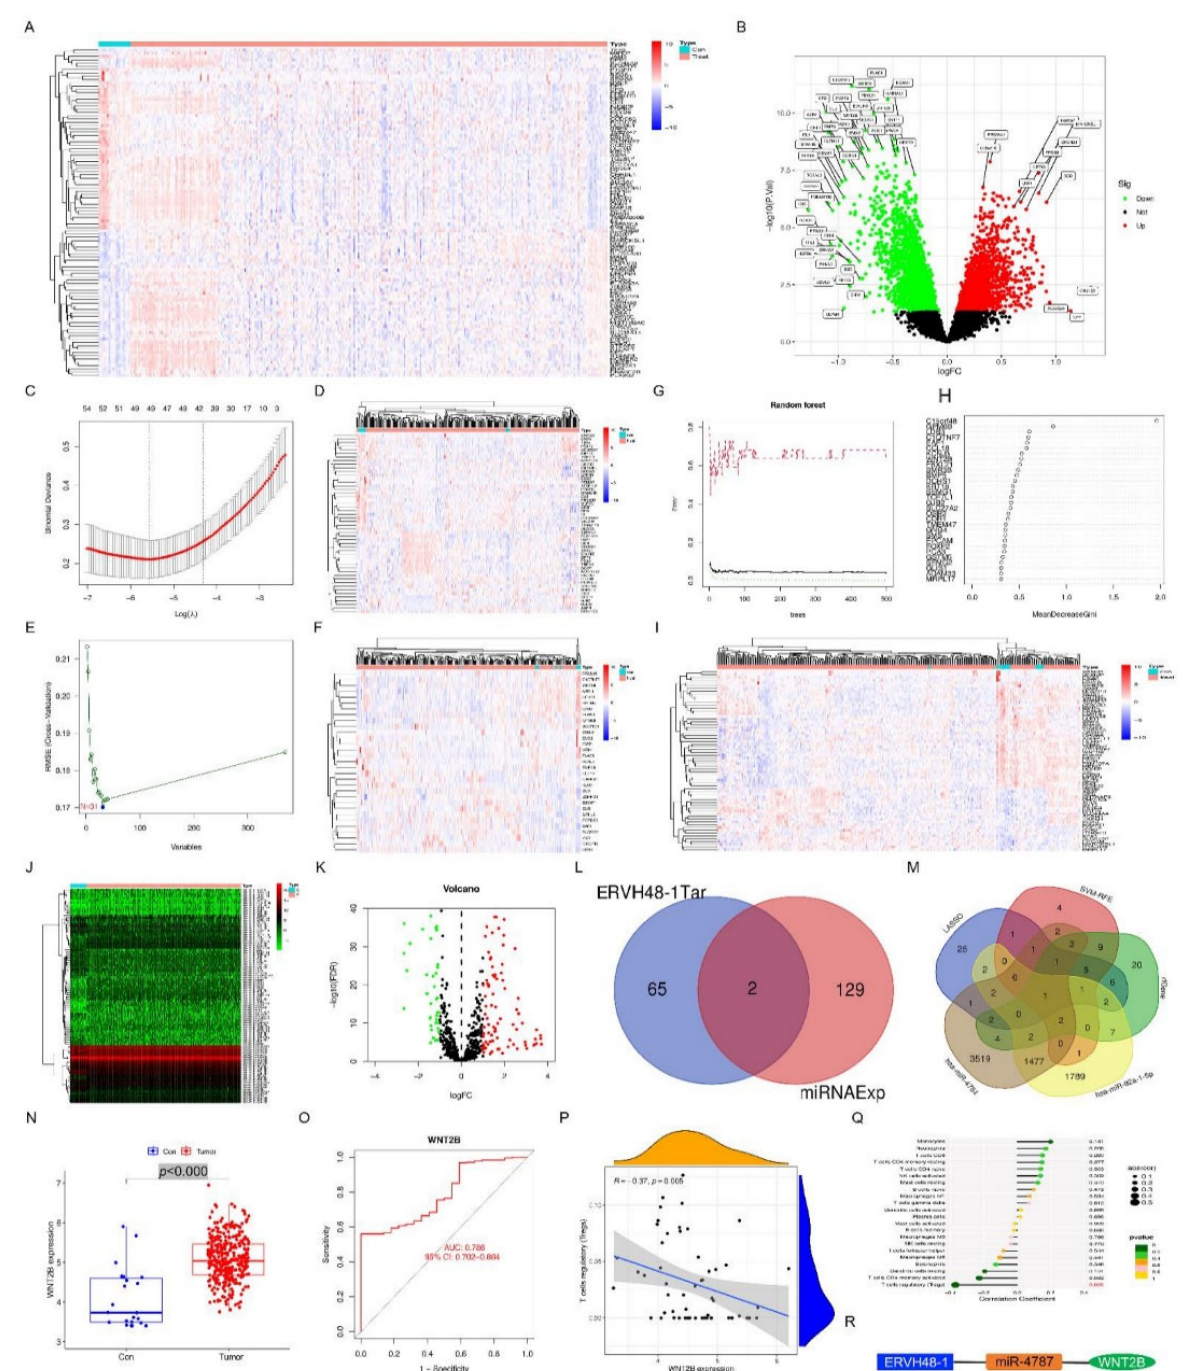
Figure 3. Construction of IP-related lncRNA–miRNA–mRNA regulatory network. ( A ) Heat map of DEGs from GSE69223, GSE103512, and GSE116918 datasets; ( B ) volcano plot of DEGs; ( C ) LASSO